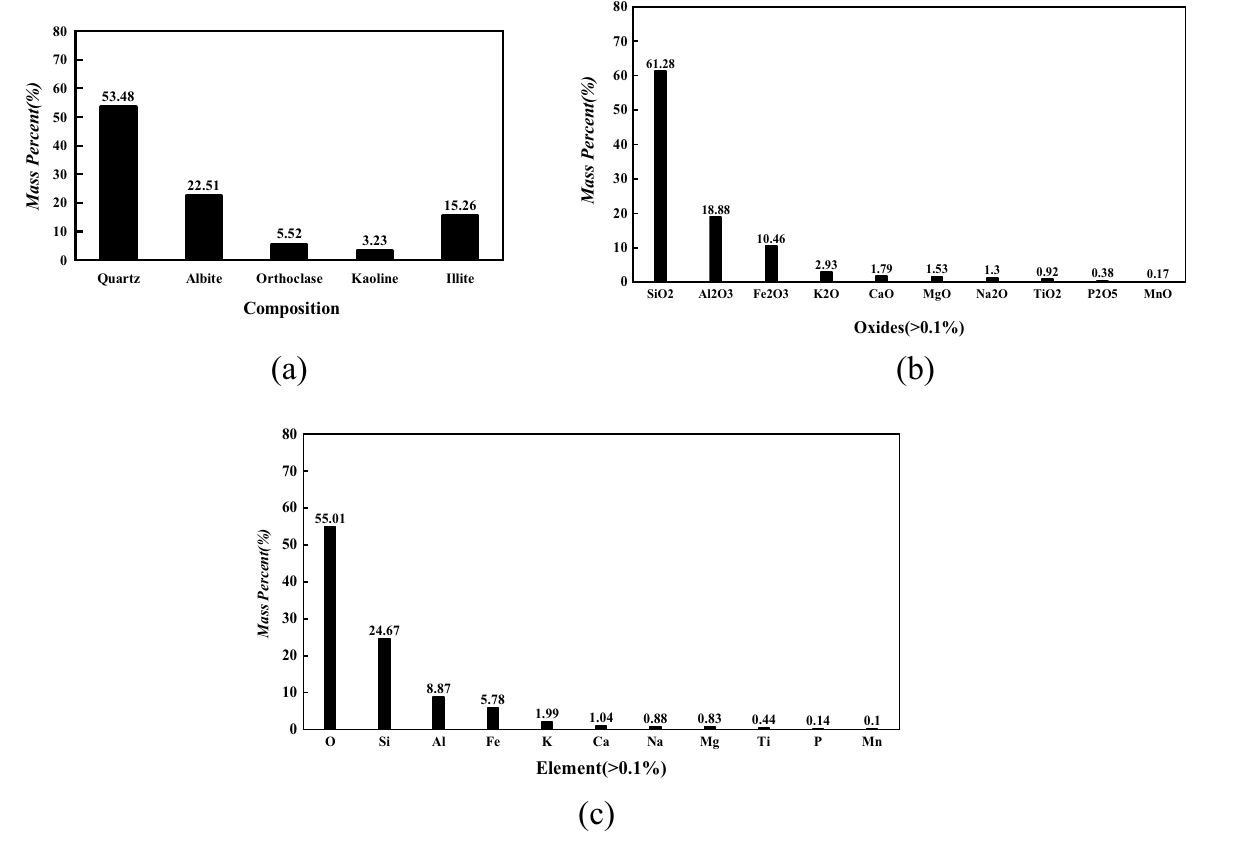
Figure 15. Mineral ( a ), elemental oxide ( b ), and element ( c ) composition of liquefied soil.